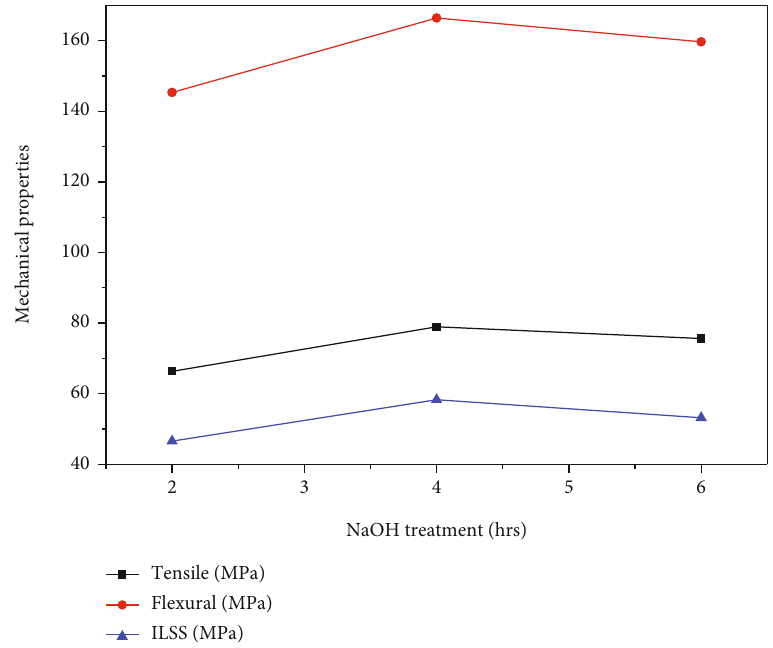
Figure 10: Mechanical properties of nanocomposites based on the NaOH treatment